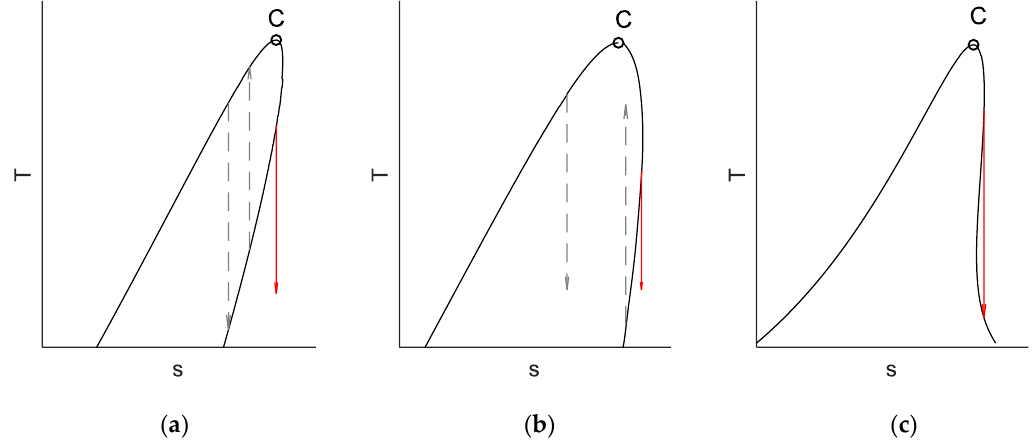
Figure 1. Schematic temperature – specific entropy ( T – s ) diagrams of two well-distinguishable dry working fluid subclasses ( a and b ) with a previously unclassifiable type ( c ). Some relevant expansion and compression routes are shown by arrows; the importance of these routes are described in the text.